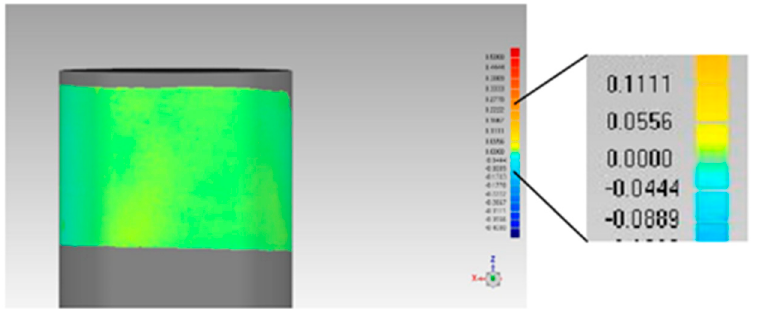
Figure 4. Calculated deviation from the comparison of the measured substrate to the theoretical design (µm).